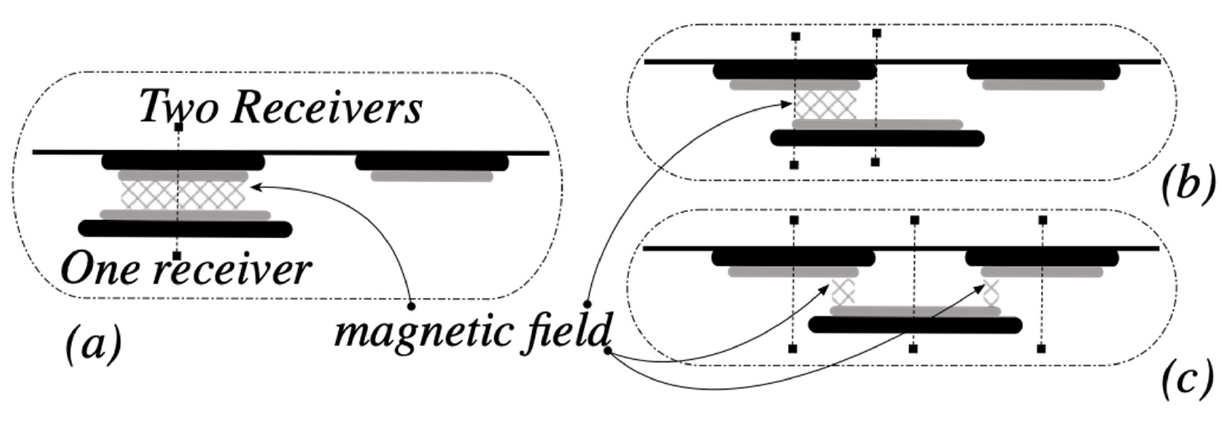
Figure 5. Wireless power transfer design for two receiver coils: ( a ) high magnetic field zone, ( b ) medium magnetic field with one receiver, ( c ) medium magnetic field with two receivers.